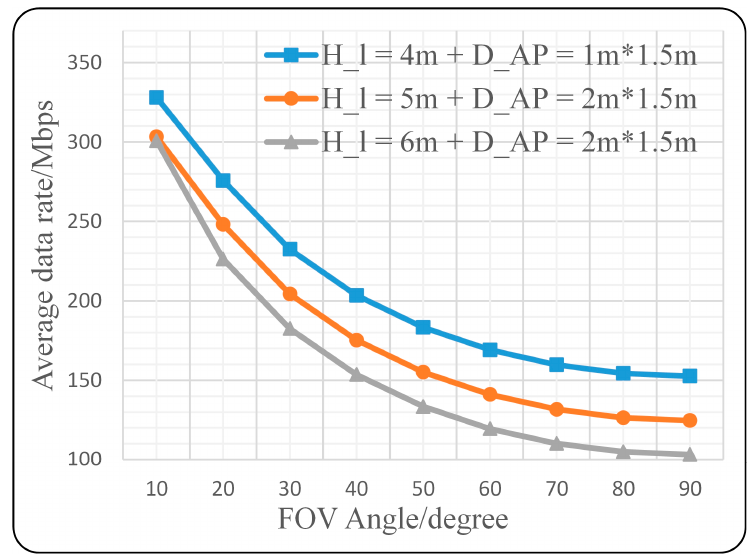
Figure 16. The average data rate under different FOV angles of receiver.